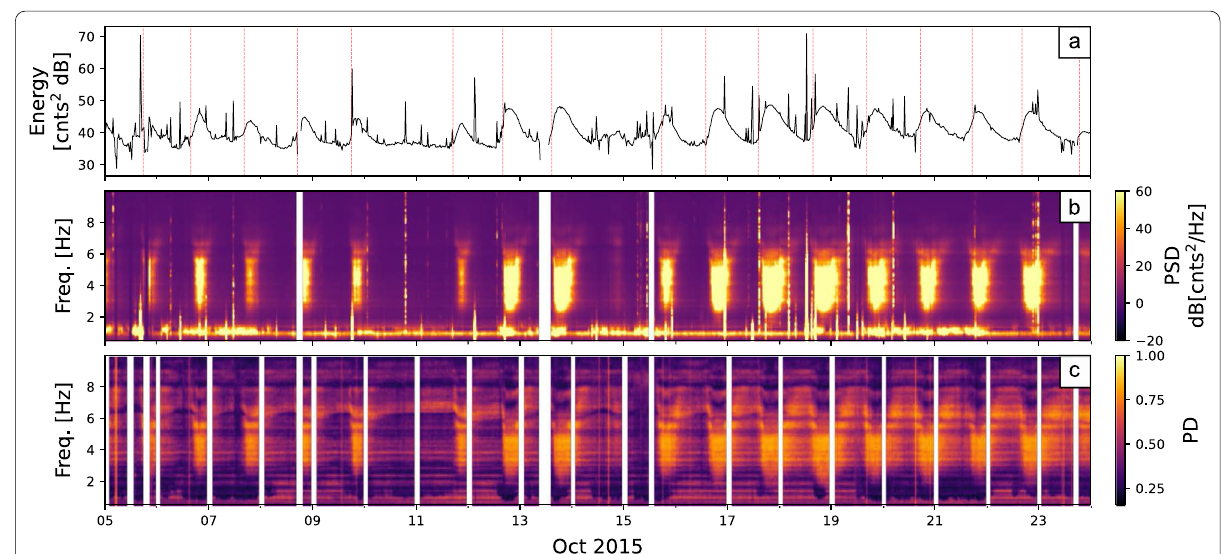
Fig. 7 Several days of October 2015 on which a BB swarm occurred. a Energy of vertical component in the range 0.5–10 Hz. b Successive 20-min ( b ) PSD and c PD side by side. Vertical red horizontal bars represent the onset of the BBs. A periodicity of 26.7